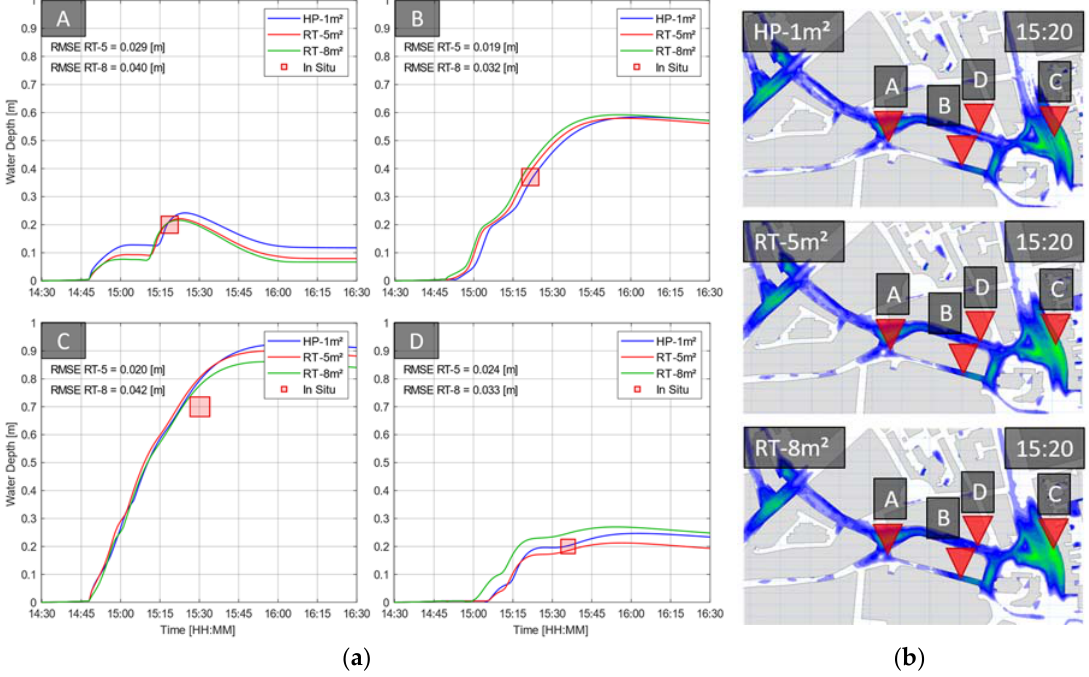
Figure 12. ( a ) Results of the different F5 simulations comparing HP ‐ 1 m 2 simulation results with RT ‐ 5 m 2 and RT ‐ 8 m 2 simulation results in front of water depth estimations from in situ observations. ( b ) Results of the same simulations shown on a 2D ‐ map and highlighted locations of in situ observations.